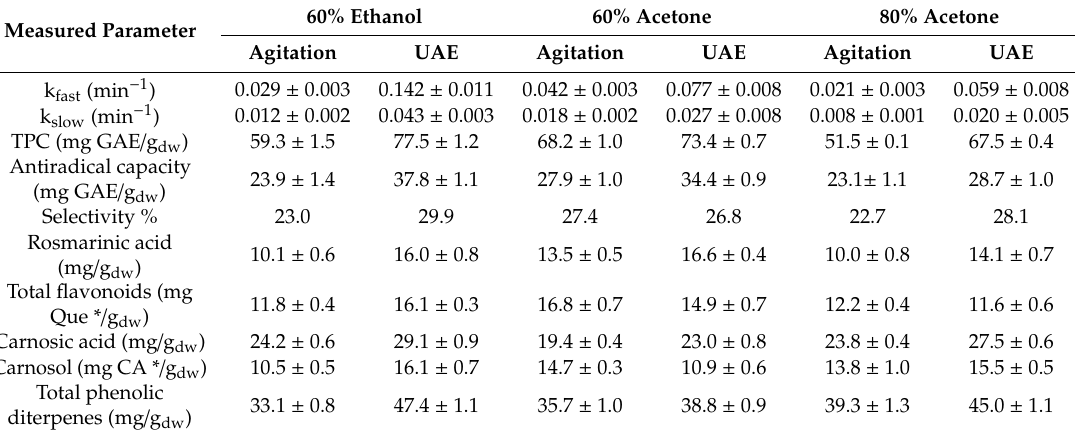
Table 5. The e ff ect of Ultrasound Assisted Extraction (UAE) on the extraction model parameters, total phenolic content (TPC), antiradical capacity, selectivity, rosmarinic acid, total flavonoids, and